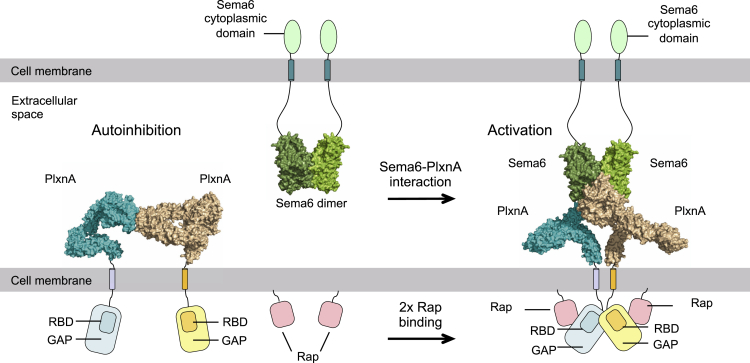
A Structural Model for PlxnA Autoinhibition Pre- and Activation Post-Ligand BindingThe PlxnA extracellular domain is represented by the 7.5 Å crystal structure of PlxnA41-10 (space group P41, see Figure S1) and superposed onto the Sema6Aecto–PlxnA21-4 complex structure (PDB: 3OKY) (Janssen et. al., 2010). The transmembrane and cytoplasmic region of PlxnA as well as the extracellular C-termini, transmembrane domain, and cytoplasmic region of Sema6 are illustrated as cartoons.